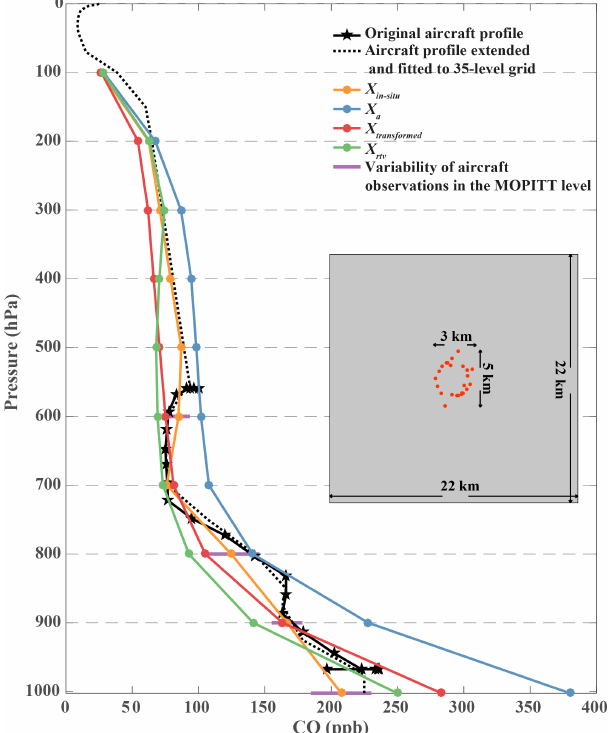
Figure 2. Example of profile comparisons for an aircraft profile sampled on 22 July 2011 during DISCOVER-AQ MD. The black solid line represents the original aircraft profile and the stars repre- sent the original aircraft observations; the black dotted line is the aircraft profile extended with CAMS reanalysis data and regrid- ded to 35-level grid. The in situ profile regridded at a 10-level grid ( x in situ ), the MOPITT a priori profile ( x a ), the in situ profile trans- formed with the MOPITT a priori and AK ( x transformed ), and the MOPITT-retrieved profile ( x rtv ) are shown in colored lines with dots. The purple bars centered at the x in situ at each MOPITT re- trieval level show the standard deviations of the original aircraft ob- servations in the MOPITT layer. Note that each MOPITT retrieval level corresponds to a uniform layer immediately above that level. The superimposed gray box shows the horizontal scale of the profile (each aircraft observation is represented by a red dot) and a MO- PITT pixel (gray